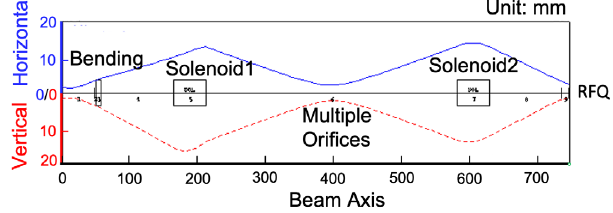
FIG. 5. Beam envelope for proton in LEBT.